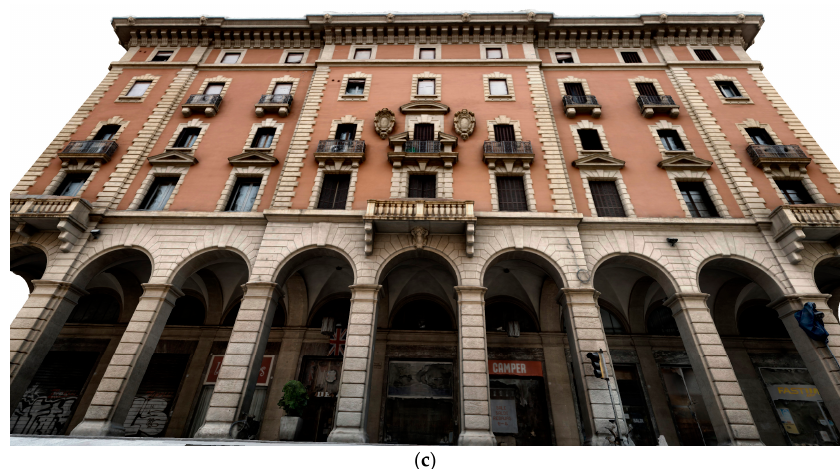
Figure 1. Results of the presented image-based 3D reconstruction of complex architectures (historical buildings with porticoes in Bologna) achieved with the presented methodology: ( a ) Palazzina in S.Tecla; ( b ) Palazzo dell’Archiginnasio; ( c ) Palazzo Assicurazioni Generali.